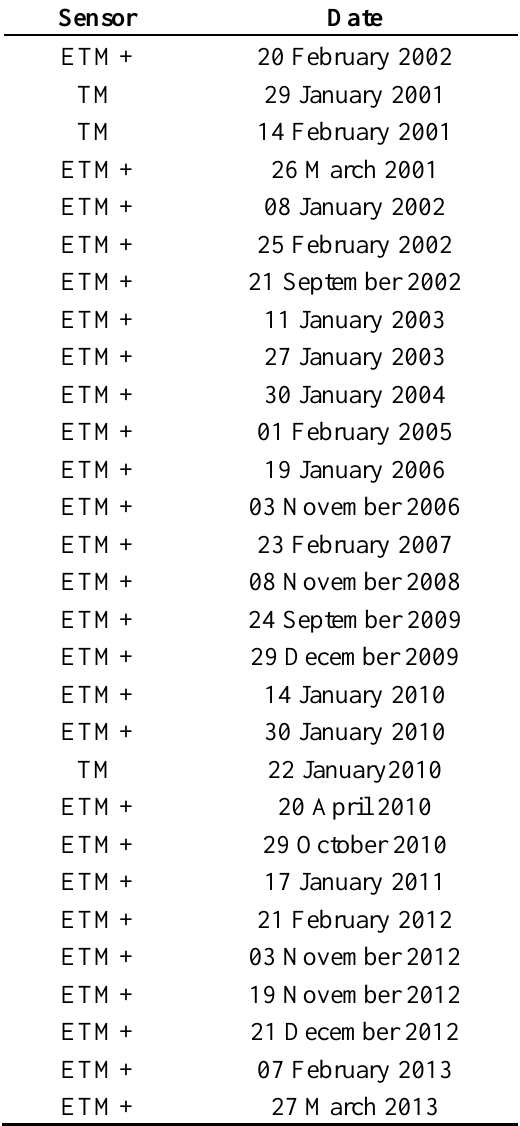
Table 1. The Path 008 Row 057 Landsat time